Question: Which kind of chart has been used to present this data?
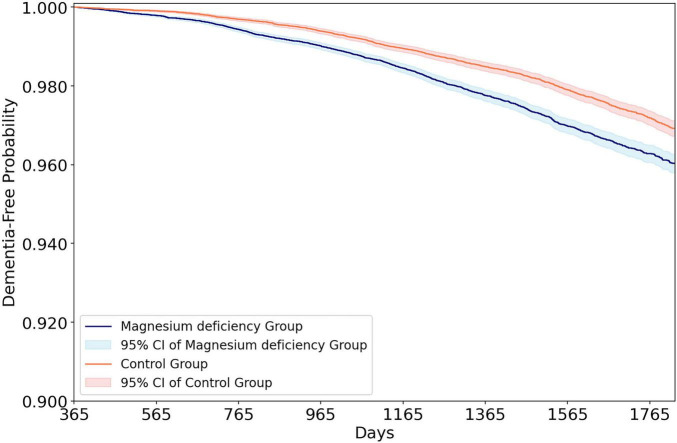
Answer: survival